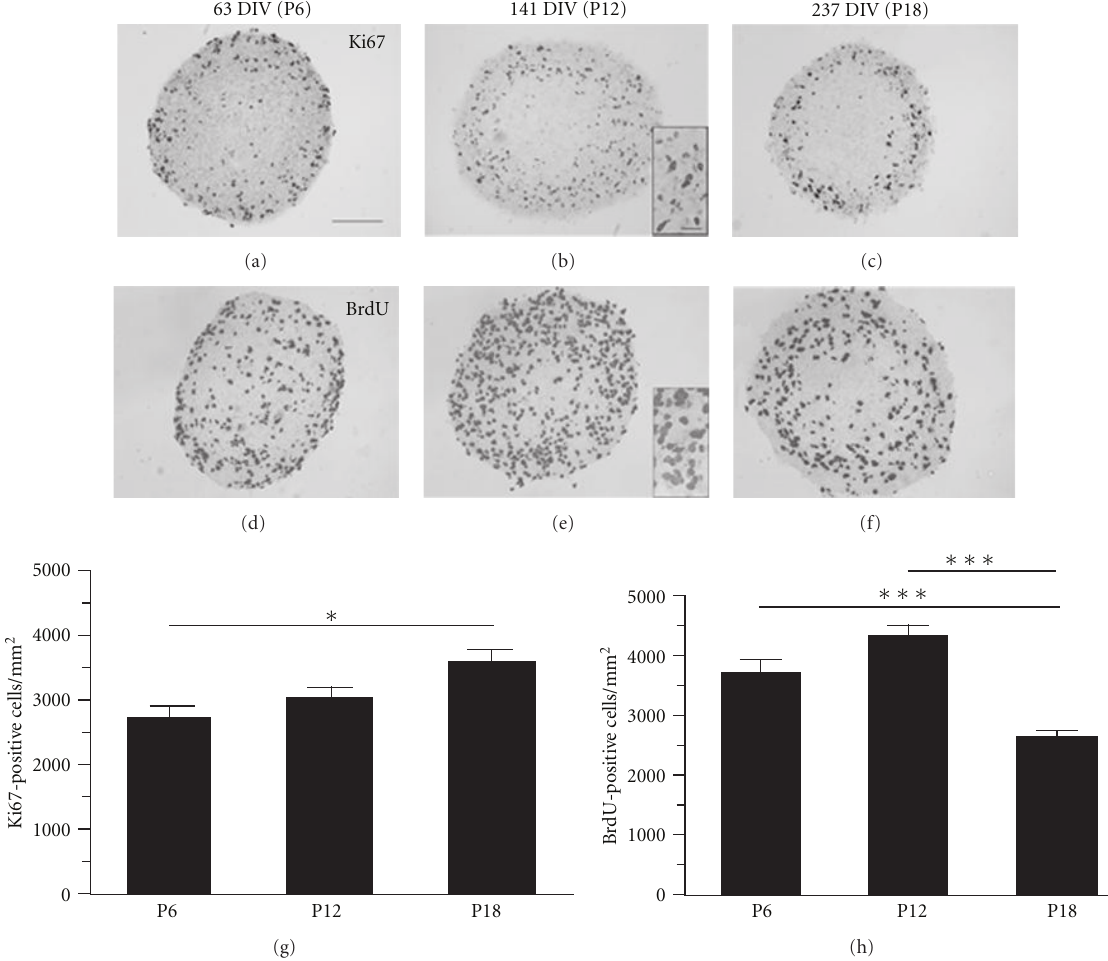
Figure 3: Proliferation in long-term propagated porcine ventral mesencephalic (VM) neural tissue spheres (NTS) visualized by Ki67 and BrdU immunostaining of histological sections. Photomicrographs of NTS showing expression of Ki67 at (a) 63 days in vitro (DIV) (passage (P) 6), (b) 141 DIV (P12), (c) 237 DIV (P18) and BrdU labelling at (d) 63DIV, (e) 141 DIV, and (f) 237DIV. Scale bars: 100 μ m (overview) and 20 μ m (insert). Quantification of Ki67 (g) and BrdU (h) expressing cells showed significantly more Ki67-positive cells at P18 as compared to P6, whereas there were significantly more BrdU-positive cells at P6 and P12 as compared to P18. Data are expressed as mean ± SEM ( n = 15–19; ∗ P < 0 . 05, ∗∗∗ P < 0 .